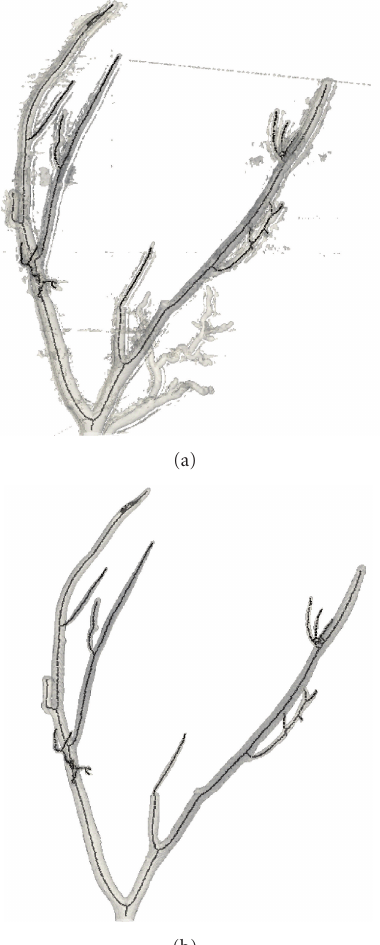
Figure 14: Specimen H61 (coronary artery branch within a human heart wall). (a) Not processed image with extracted center line; (b) Segmented processed image with extracted center